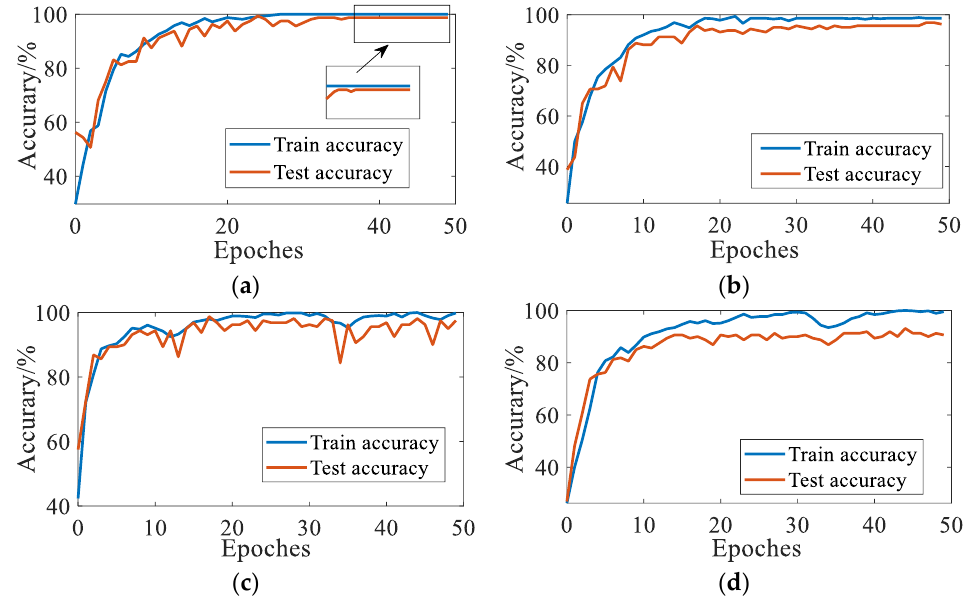
Figure 7. Diagnostic accuracy of different models. ( a ) Mel - Mixup; ( b ) Mel - Basic data enhancement; ( c ) Time - frequency - Mixup; ( d ) Time - frequency - Basic data enhancement.